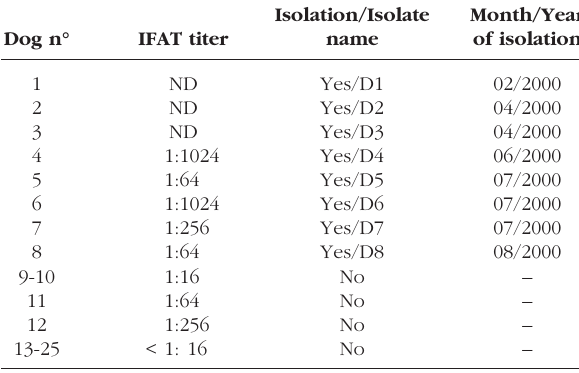
Table I. – Indirect fluorescent antibody test (IFAT) for toxoplasmosis in dog sera from Minas Gerais, Brazil, and T. gondii isolates obtained from muscle samples.